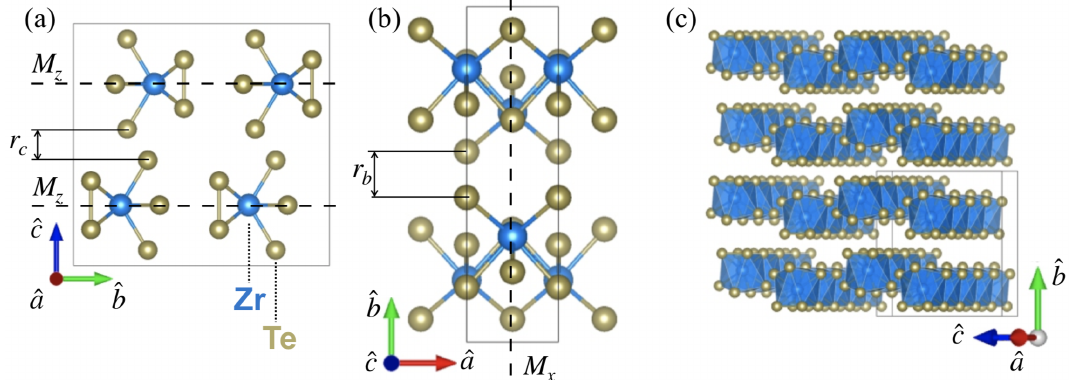
Figure 2: (a,b) Refined crystal structure of ZrTe respectively. (c) Polyhedral representation of the ZrTe chains along the a -axis and 2D planes stacked along the b -axis are clearly visible. Dashed lines indicate the position of reflection symmetry